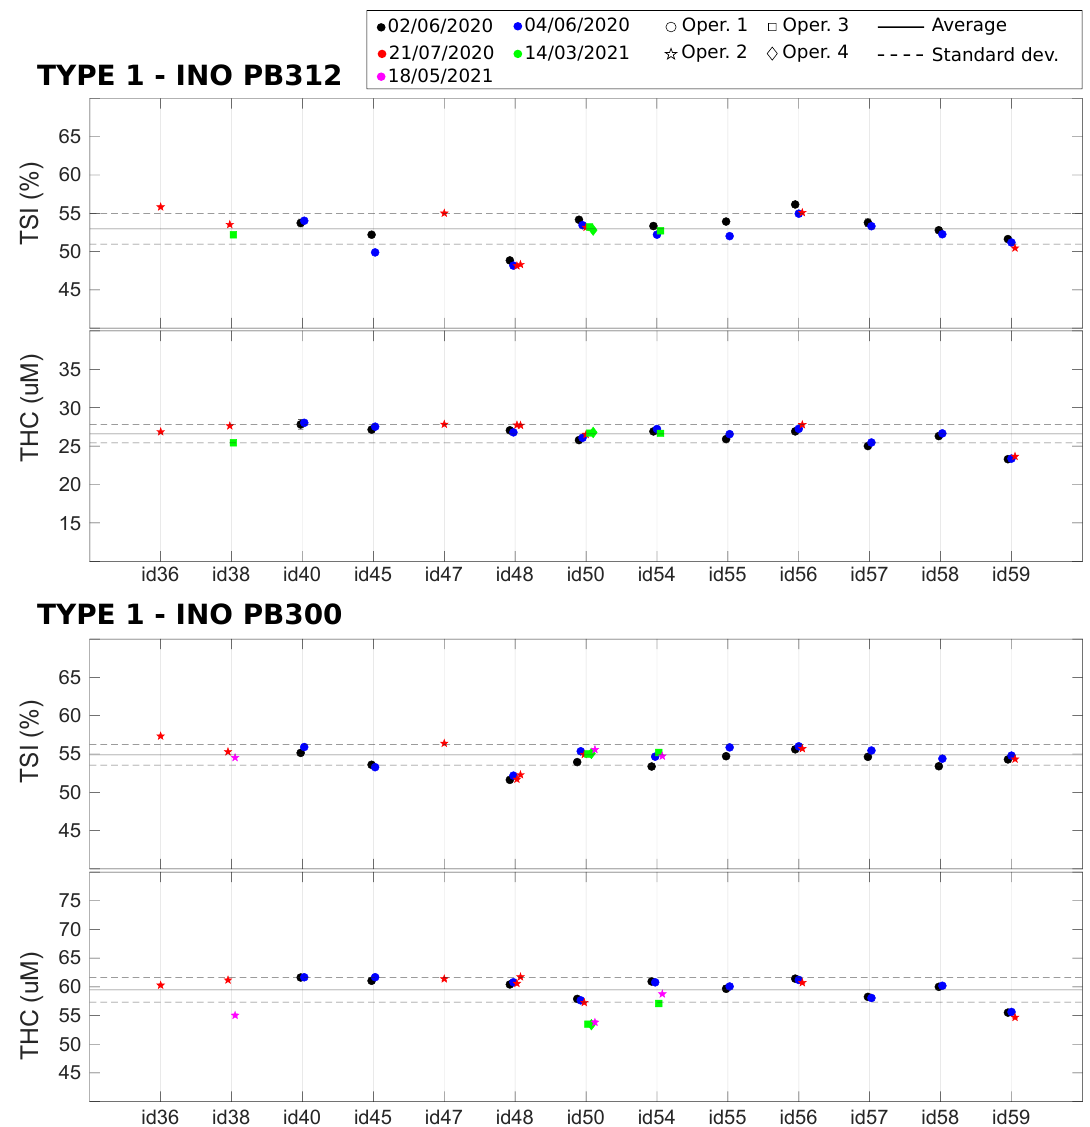
Figure 4. Device characterization of Type 1 phantoms, performed on different days and months by different operators. Horizontal lines represent the average (solid line) ± standard deviation (dashed lines) over all the